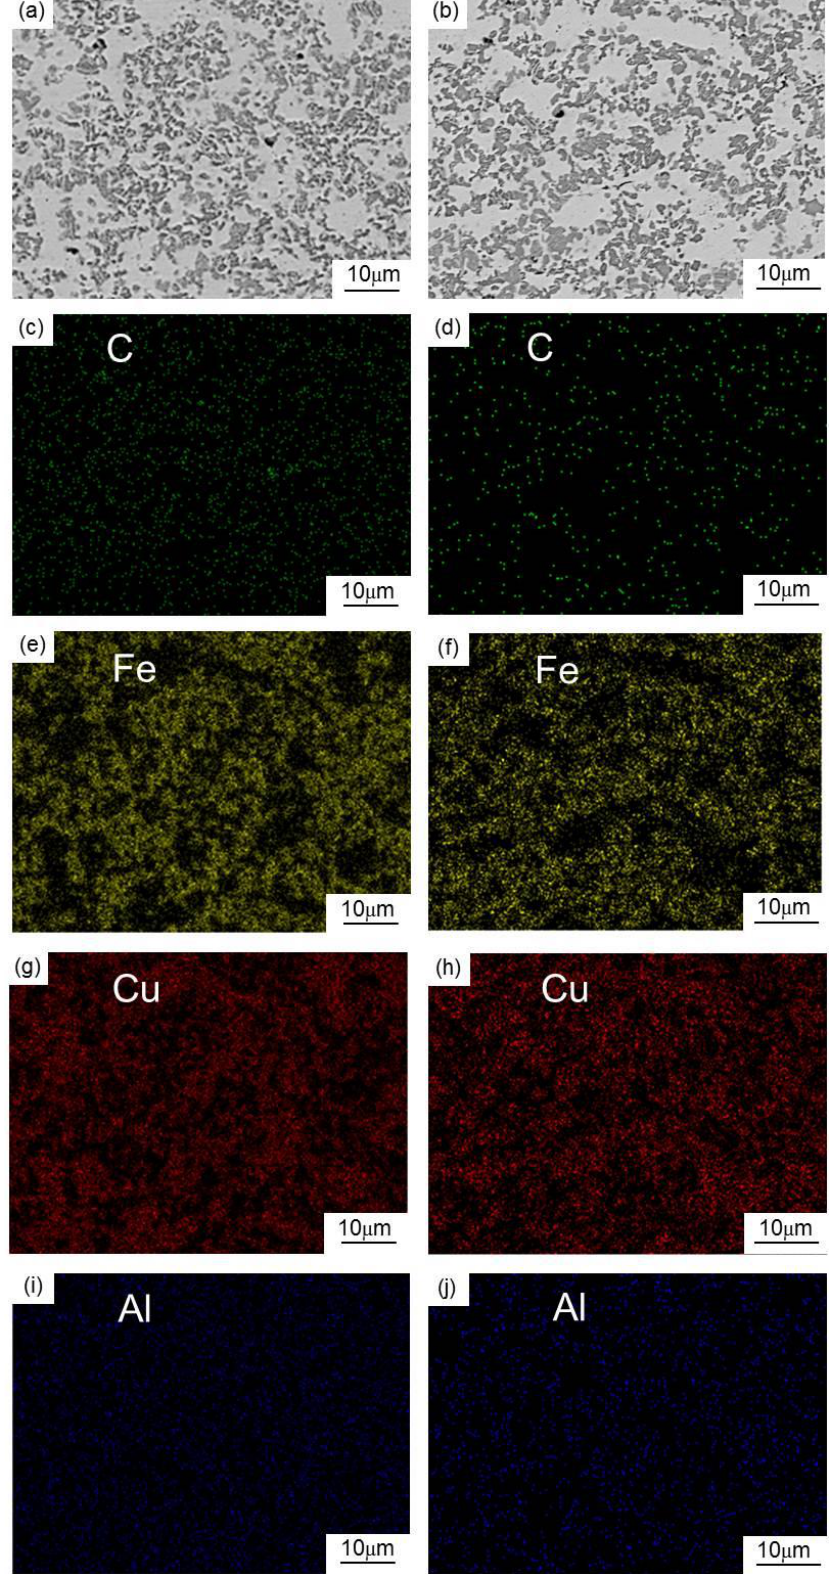
Figure 3. BSEM of the matrices of the ( a ) MCMB-25 and ( b ) GrF-25 composites, and energy dispersive spectroscopy (EDS) maps of the matrices of the ( c , e , g , i ) MCMB-25 and ( d , f , h , j ) GrF-25 composites.